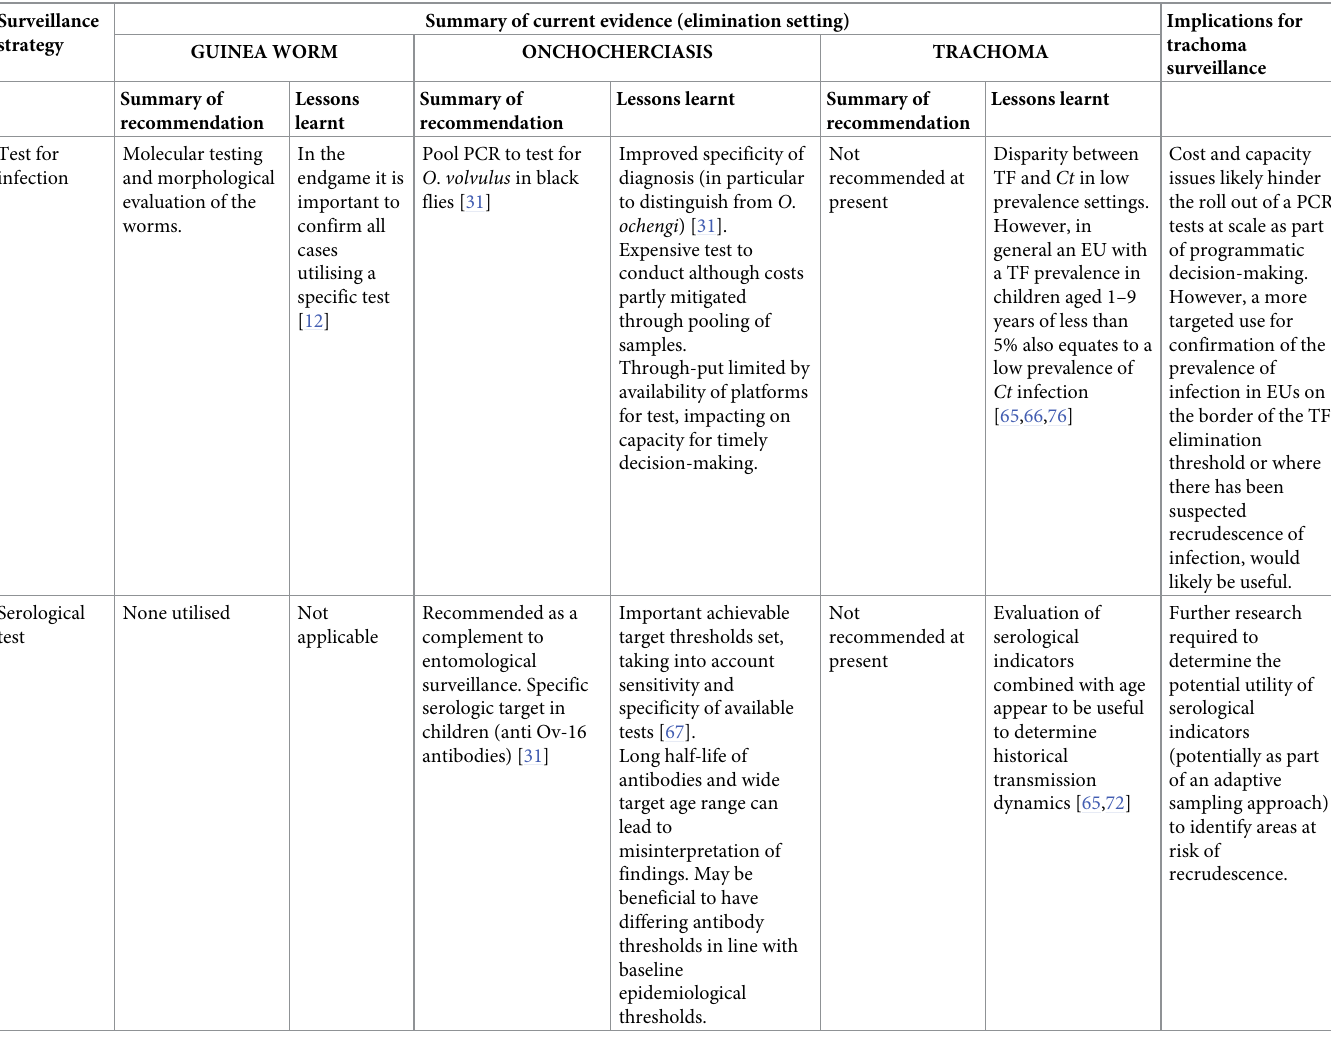
Table 4. Summary of studies evaluating use of laboratory confirmation for surveillance. Surveillance